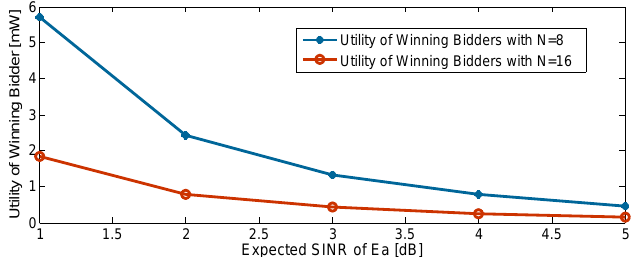
Figure 6. Utility of winning bidder vs. expected SINR at Ea.